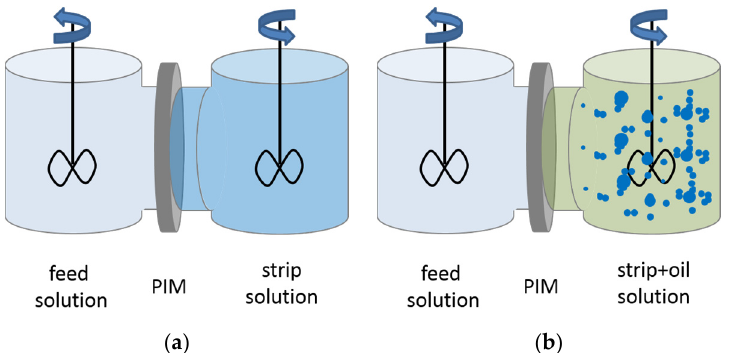
Figure 2. Schematic drawing of the two ‐ cell setup for conventional PIM ( a ) and PIM with strip dispersion ( b ).